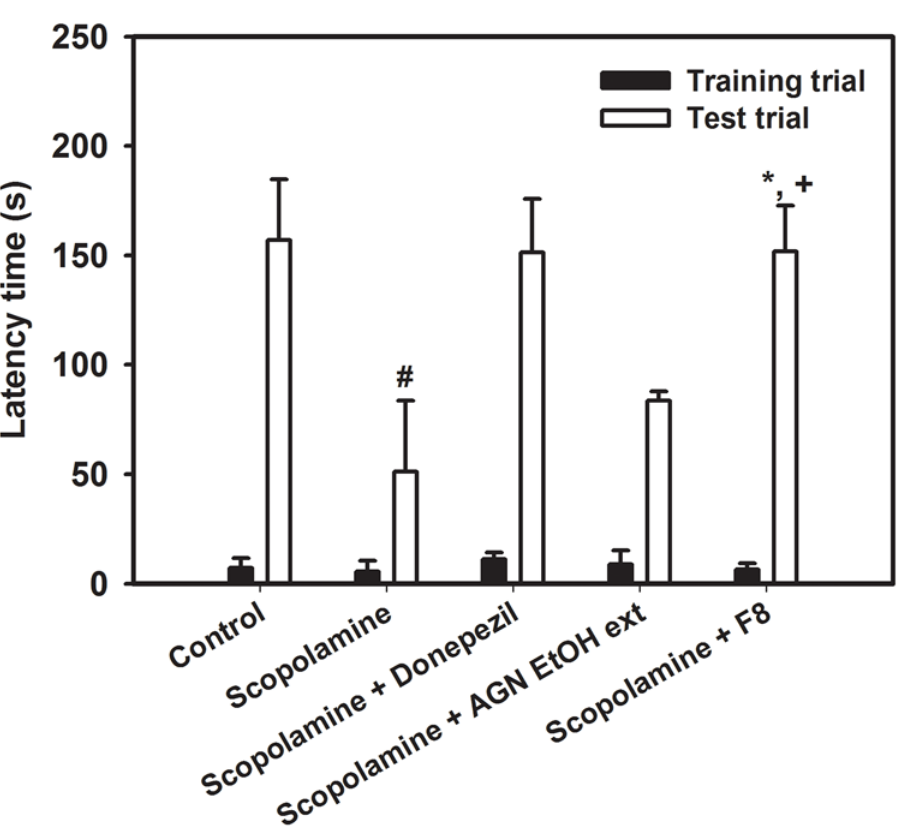
Fig 8. The influence of AGN EtOH ext and F8 on the scopolamine-induced memory impairment mice, evaluated by passive avoidance test. # p < 0.05, compared to control group; * p < 0.05, compared to scopolamine-treated group; + p < 0.05, compared to (scopolamine + AGN EtOH ext)-treated group. Two-tailed t -test is used for the statistical analysis. Each point represents mean ± SD (n =